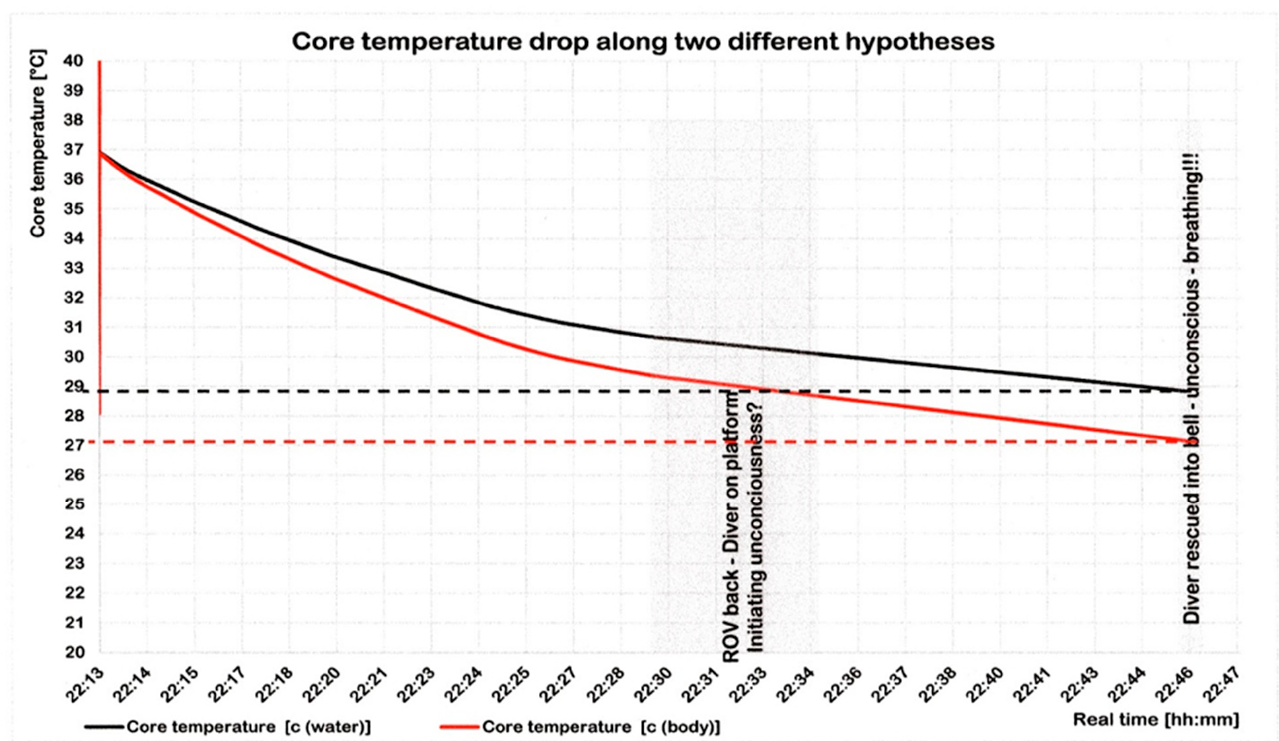
Figure 11. Core temperature. During 33 min after the umbilical had severed, the temperature de- creased to 28.8 °C (black: hypothesis 1) and to about 27.2 °C (red: hypothesis 2). decreased to 28.8 ◦ C (black: hypothesis 1) and to about 27.2 ◦ C (red: hypothesis